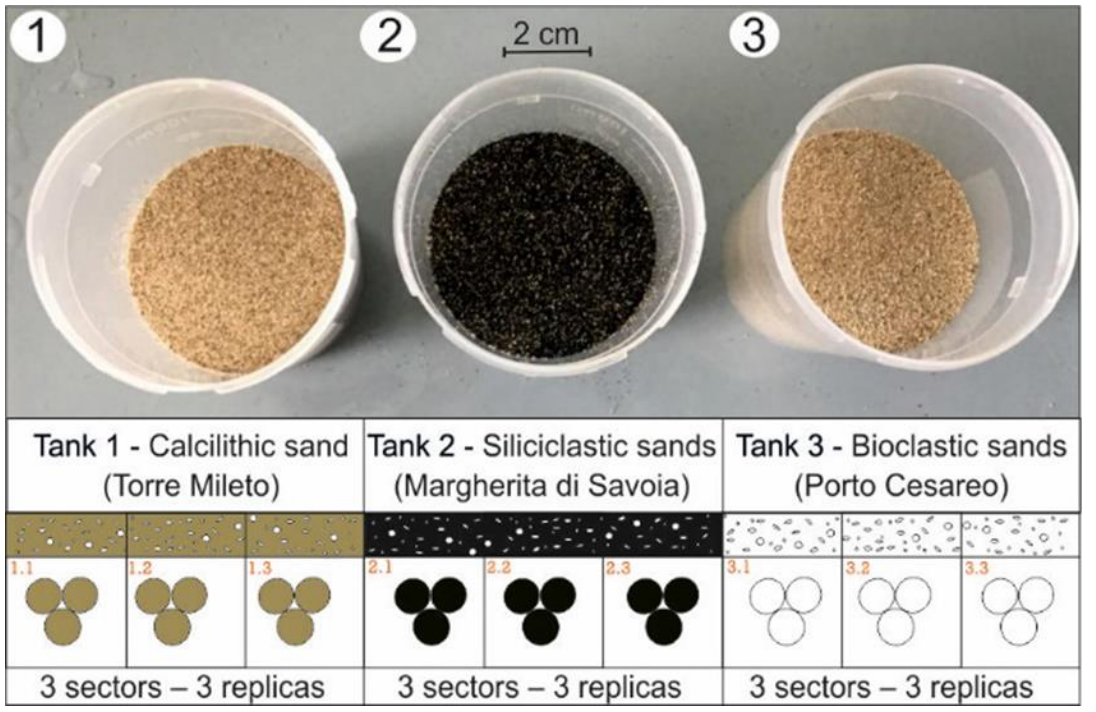
Figure 4. Scheme of the experimental tanks (1, 2, and 3) in which different sands were used. Each tank was divided into three sectors (e.g., tank 1 is divided into sectors 1.1, 1.2, and 1.3). Each sector contained three biological replicas represented by three reef fragments. For each tank, it was therefore possible to have nine replicas for each test.